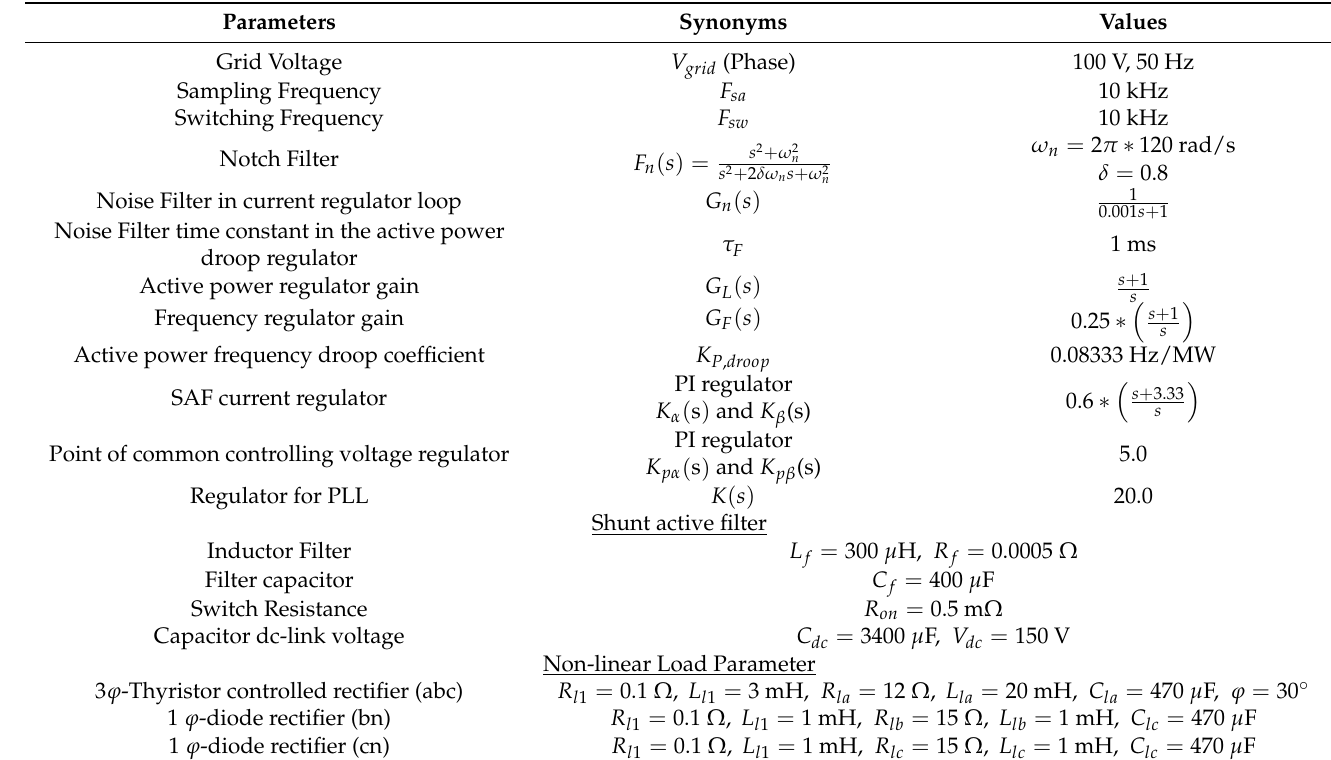
Table A1. System parameters.